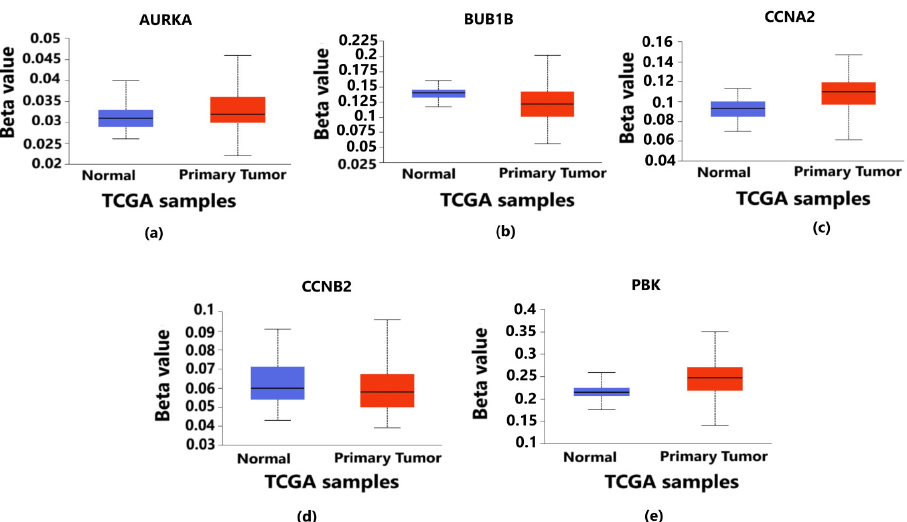
Figure 7. Level of promoter methylation corresponding to 5 hub genes in breast cancer. It provides the information about whether the overexpressed genes are hypermethylated or hypomethylated as both play vital roles in the progression and metastasis of breast cancer. The blue color box plot denotes normal TCGA samples without breast cancer, and the red color box plot represents the TCGA samples with breast cancer. ( a ) Methylation level of AURKA gene in which the methylation levels of tumor samples are higher than those of normal samples. ( b ) Methylation level of BUB1B gene in which the methylation levels of tumor samples are lower than those of normal samples. ( c ) Methylation level of CCNA2 gene in which the methylation levels of tumor samples are higher than those of normal samples. ( d ) Methylation level of CCNB2 gene in which the methylation levels of tumor samples are lower than those of normal samples. ( e ) Methylation level of PBK gene in which the methylation levels of tumor samples are higher than those of normal samples. In all the above cases, the p -value is less than 0.05 ( p < 0.05).